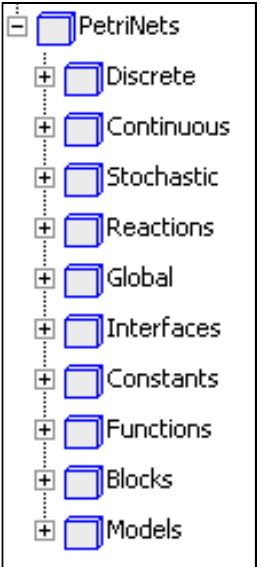
Figure 4: Structure of the Petri Net